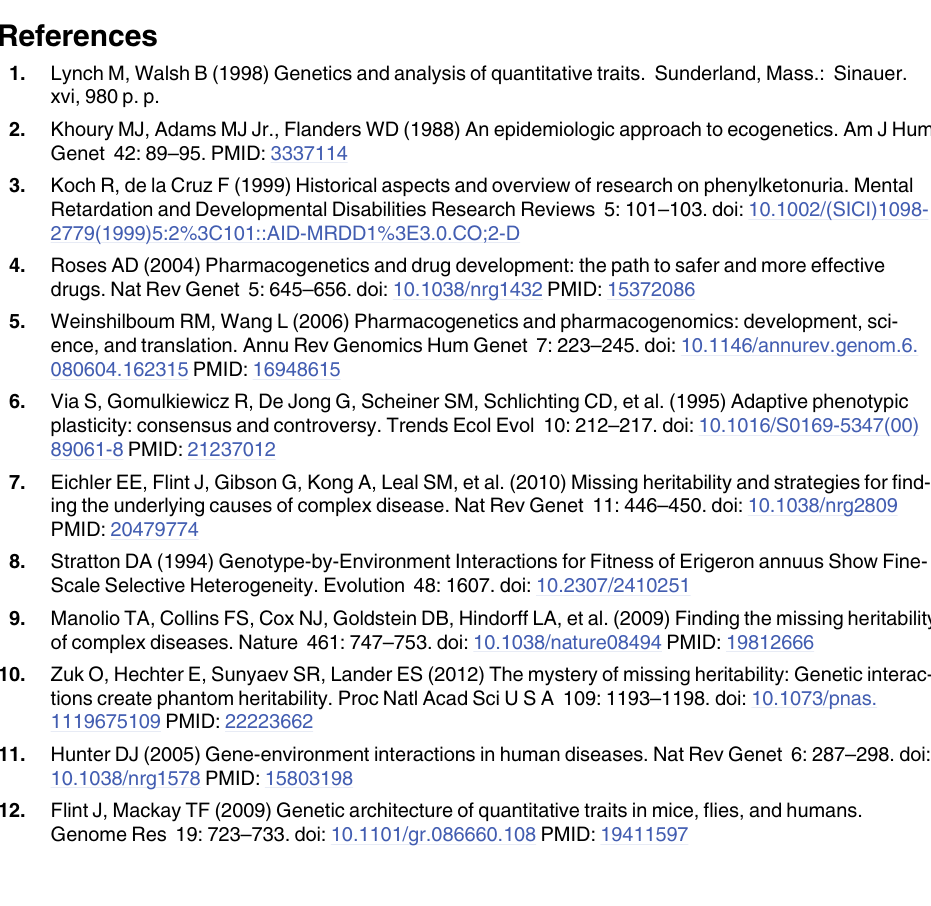
S1 Table. Differential expression results between SE and NSE samples. S2 Table. Gene Ontology enrichment for genes that are differentially expressed (Benja- mini-Hochberg FDR < 0.01) with greater than two-fold change. S3 Table. List of se-eQTLs tested for selectionand the selectionscores/p-values. The higher expressed exposure-type is indicated when significant (Benjamini-Hochberg FDR < 0.05). The exposure-type with the stronger effect according to the effect-size test is indicated, and the analysis from where the se-eQTL was obtained is also